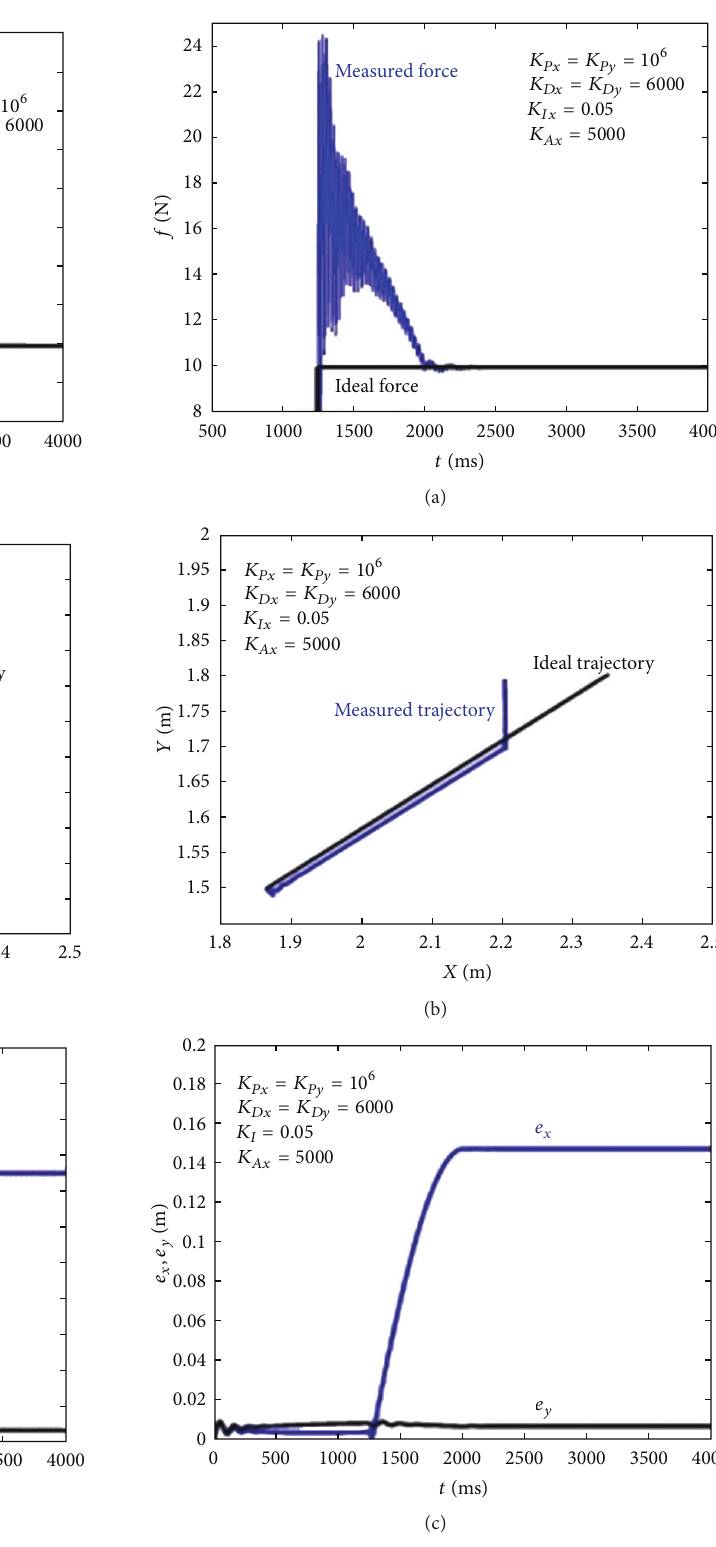
Figure 27: Force (N), position (m), and error position (m) of P system assuming that 𝐾 𝐴 = 5000